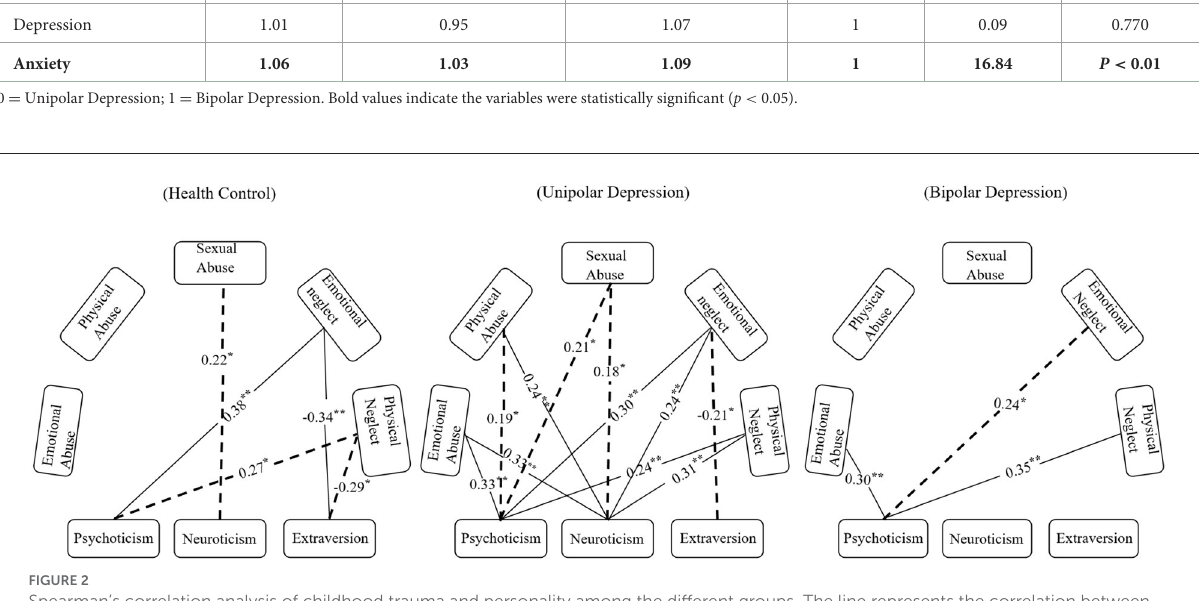
childhood trauma is positively correlated with neuroticism